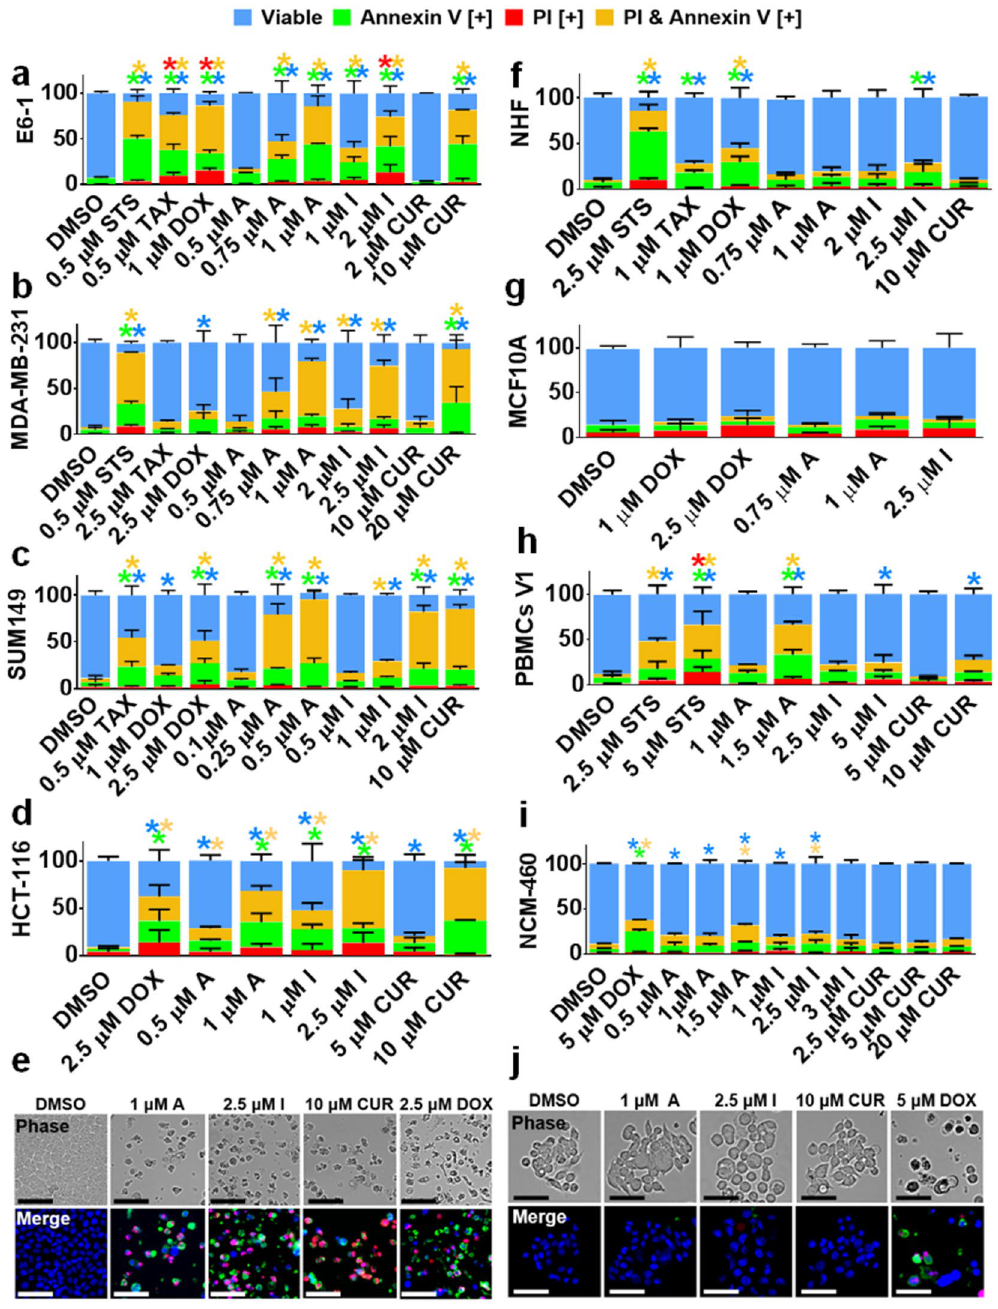
Figure 3. Curcumin Analogs Induce Apoptosis Selectively in Several Cancer Cell Lines. Following treatment with specified doses, cells were stained for Annexin V and PI. ( a–d ) Cancerous cell lines tested. Results were obtained using image-based cytometry. ( e ) HCT-116 micrographs at 72 hours. Top: Bright field images at 400x magnification. Bottom: Fluorescent images stained with Annexin V (green), PI (red), and Hoechst (blue) at 400x magnification. ( f–i ) Non-cancerous cell lines tested. Results were obtained using image-based cytometry. ( j ) Normal colon cells (NCM460) micrographs at 72 hours. Top: Bright field images at 400x magnification. Bottom: Fluorescent images stained with Annexin V (green), PI (red), and Hoechst (blue) at 400x magnification. For each graph the Y-axis is representative of percent of cells positive for Annexin V (green), PI (red), Annexin V and PI (yellow), or negative for both Annexin V and PI (blue). Values are expressed as a mean ± SD from three independent experiments. Results shown are at 48 hours with the exception to HCT- 116 and NCM460, which were at 72 hours. For the microscopic images the scale bar is 50 microns. Images are representative of three independent experiments. Statistical calculations were performed using Two-Way ANOVA multiple comparison. * p < 0.05 vs Control